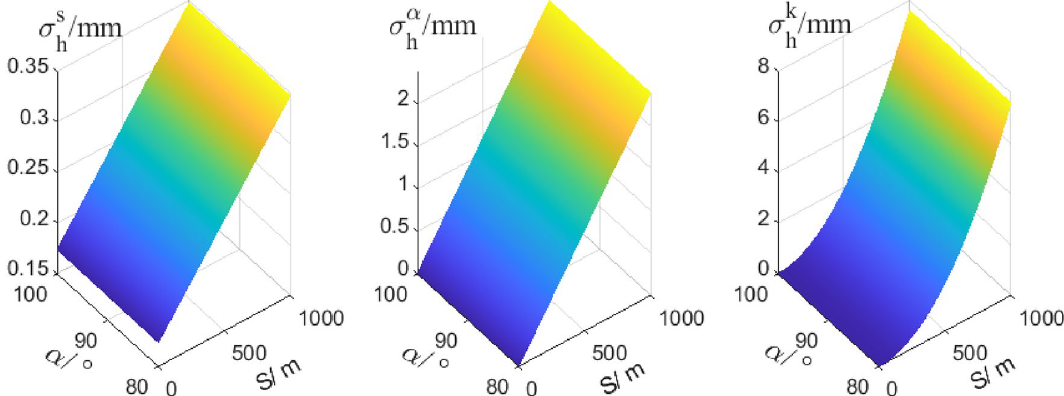
Figure 2. Errors analysis of trigonometric levelling in 1000 m.